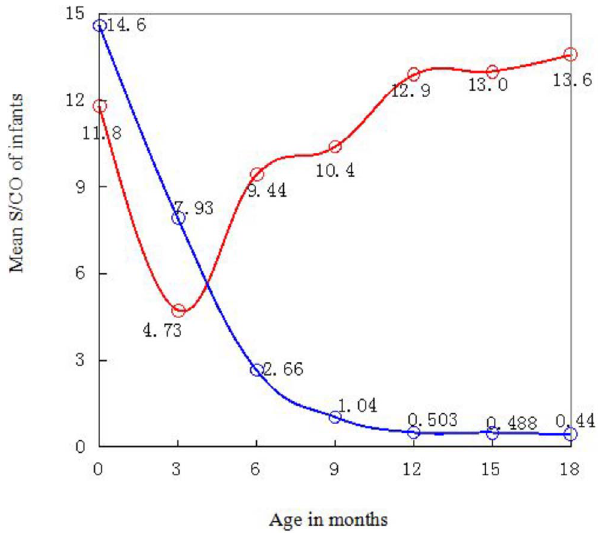
Figure 4. HIV sero-status of infants. Red and blue lines indicate infected and uninfected infants, respectively. Calculations were based on 943 DBSs from 256 uninfected infants and 82 DBSs from 24 infected infants. At each month of age, sample sizes of infected babies were all $ 11 except at 9 months of age with 6 samples; sample sizes of uninfected babies were all $ 93.